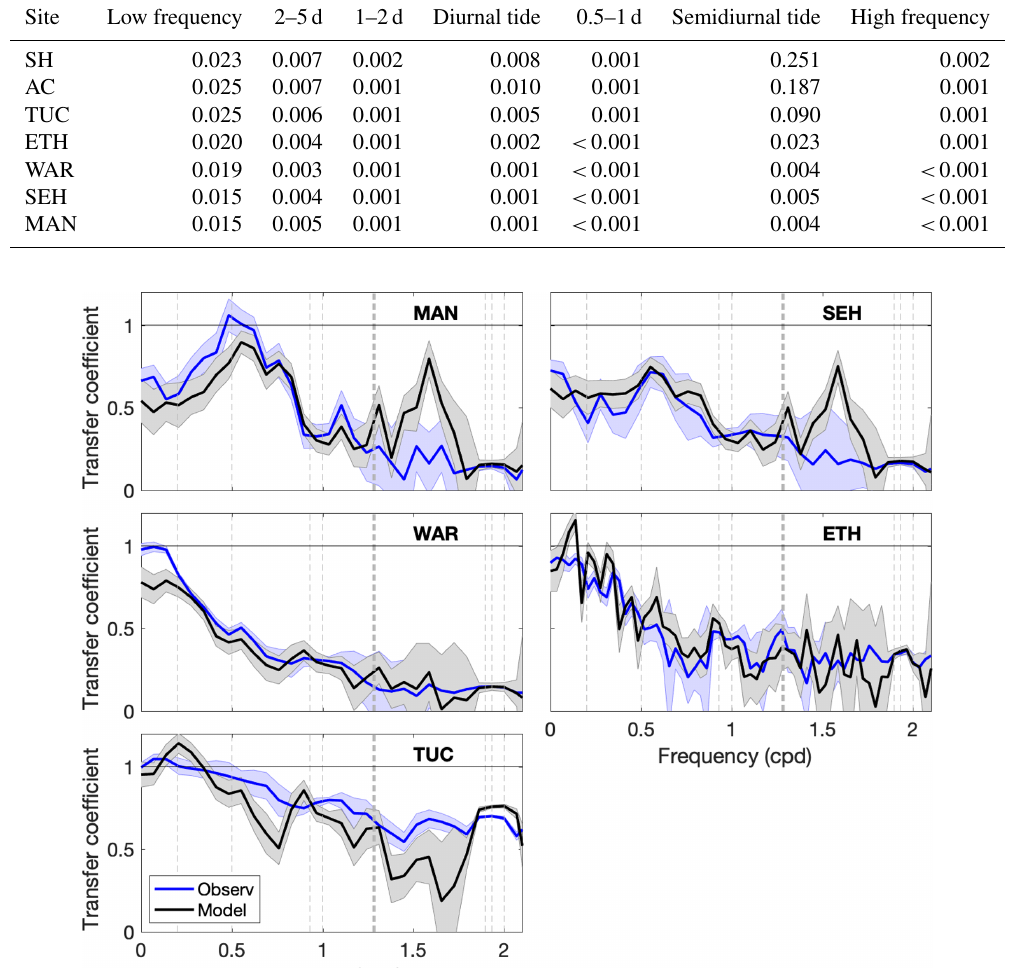
Table 2. Sum of energy (m 2 ) in the different bands of the spectra computed for the period 2007–2018 (or longest available record) using a 29d Hanning window with overlapping (50%) data segments.